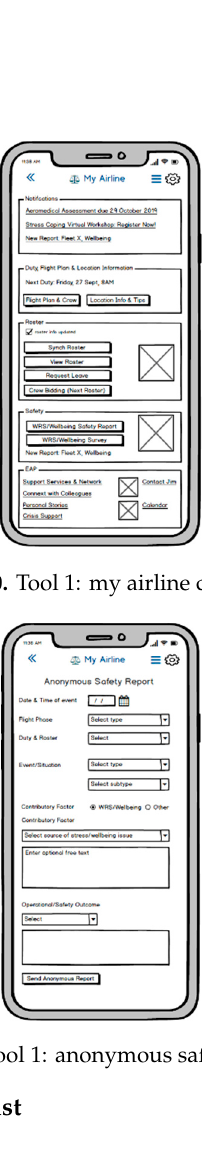
Figure A9. Tool 1: Tracking and reporting dashboard.